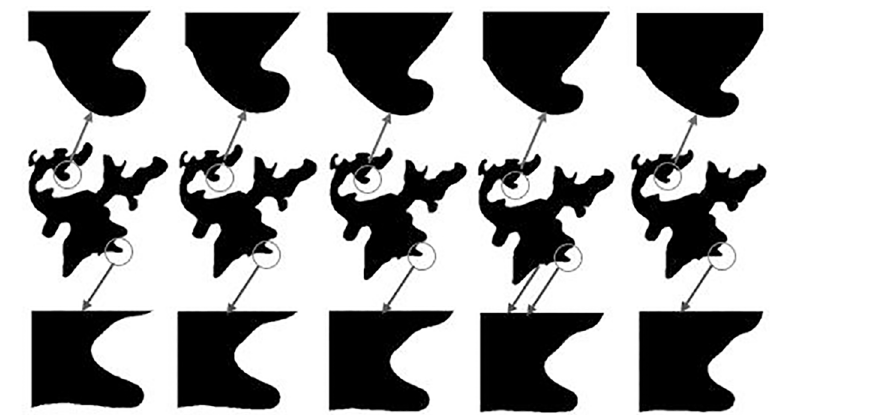
Fig 3. The morphing effects of different features with g interval 0.1.